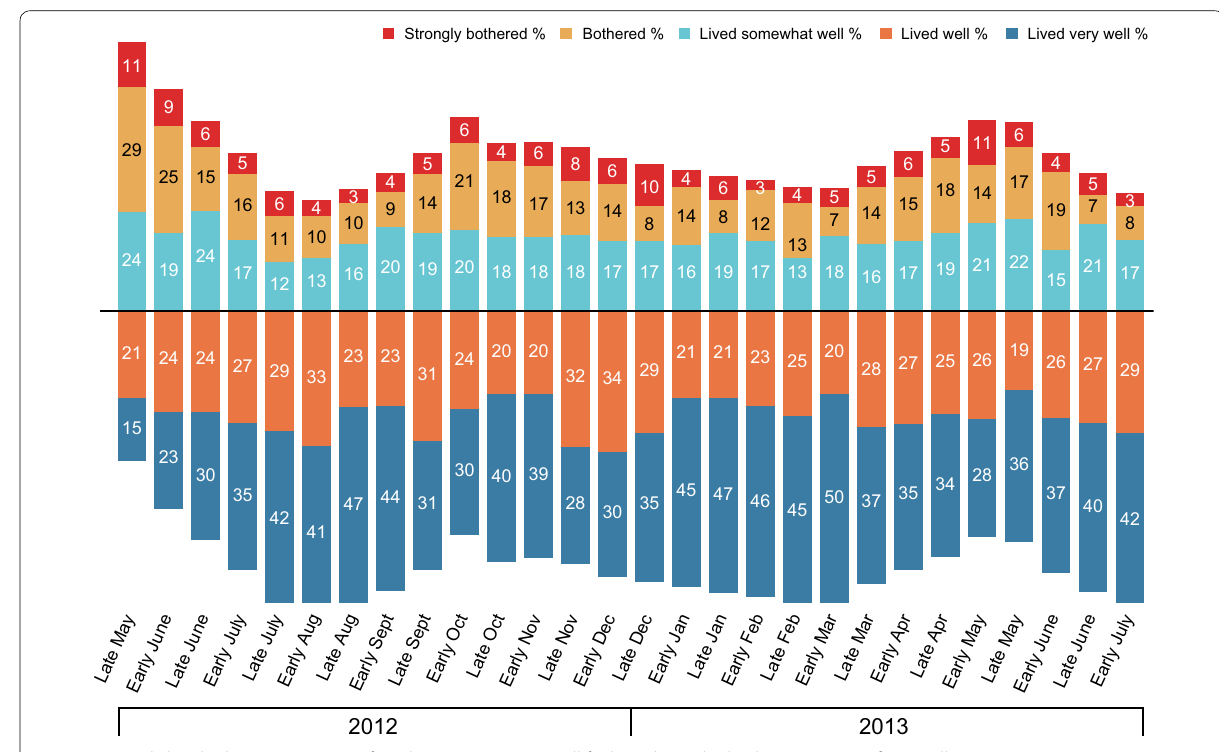
and a second peak in spring 2013. Very similar changes over time were observed when considering the percent- age of patients who reported having missed at least one day of work in a given fortnightly period (Additional file 3: Figure S2). Overall, fewer than 10% of the partici- pants reported having missed at least 1 day of work per fortnight. The proportion of patients missing at least 1 day of work in a given fortnightly period appeared to be lower in France than in Spain and Italy.